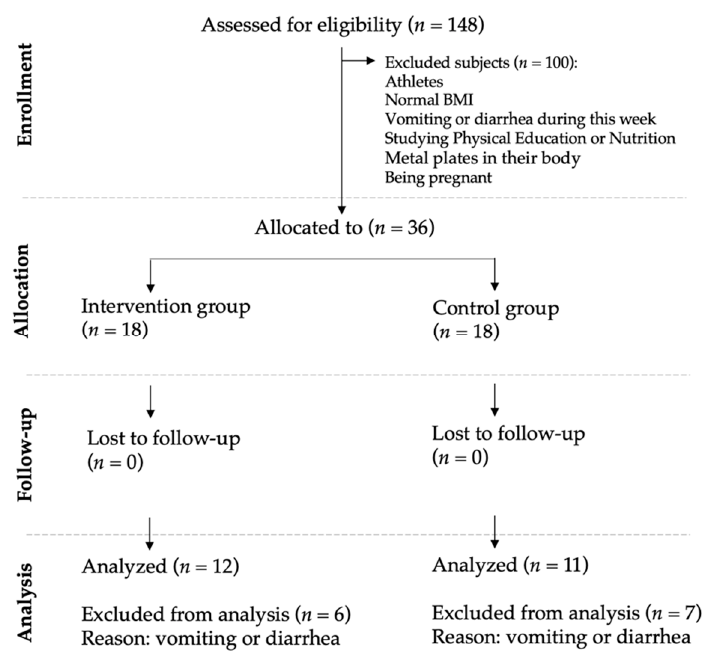
Figure 2. Consort diagram of the participant flow .